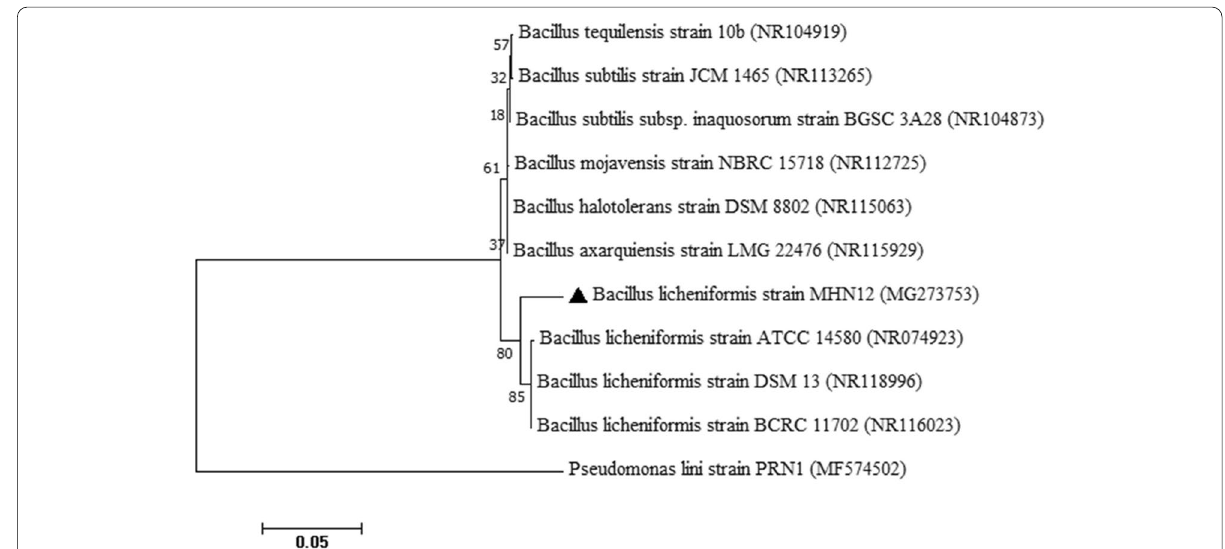
Fig. 1 Phylogenetic tree based on 16s rRNA gene sequences of MHN12 with closest related sequences obtained from NCBI